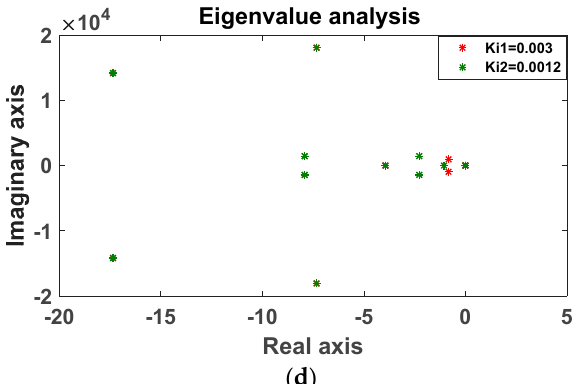
Figure 5. Impact of variation in relation to control parameters (boost converter). ( a ) Variation in K p in 12-kW boost converter; ( b ) variation in K i in 8-kW boost converter; ( c ) variation in K p in 8-kW boost converter on DC grid; ( d ) variation in K i in 8-kW boost converter on DC grid.